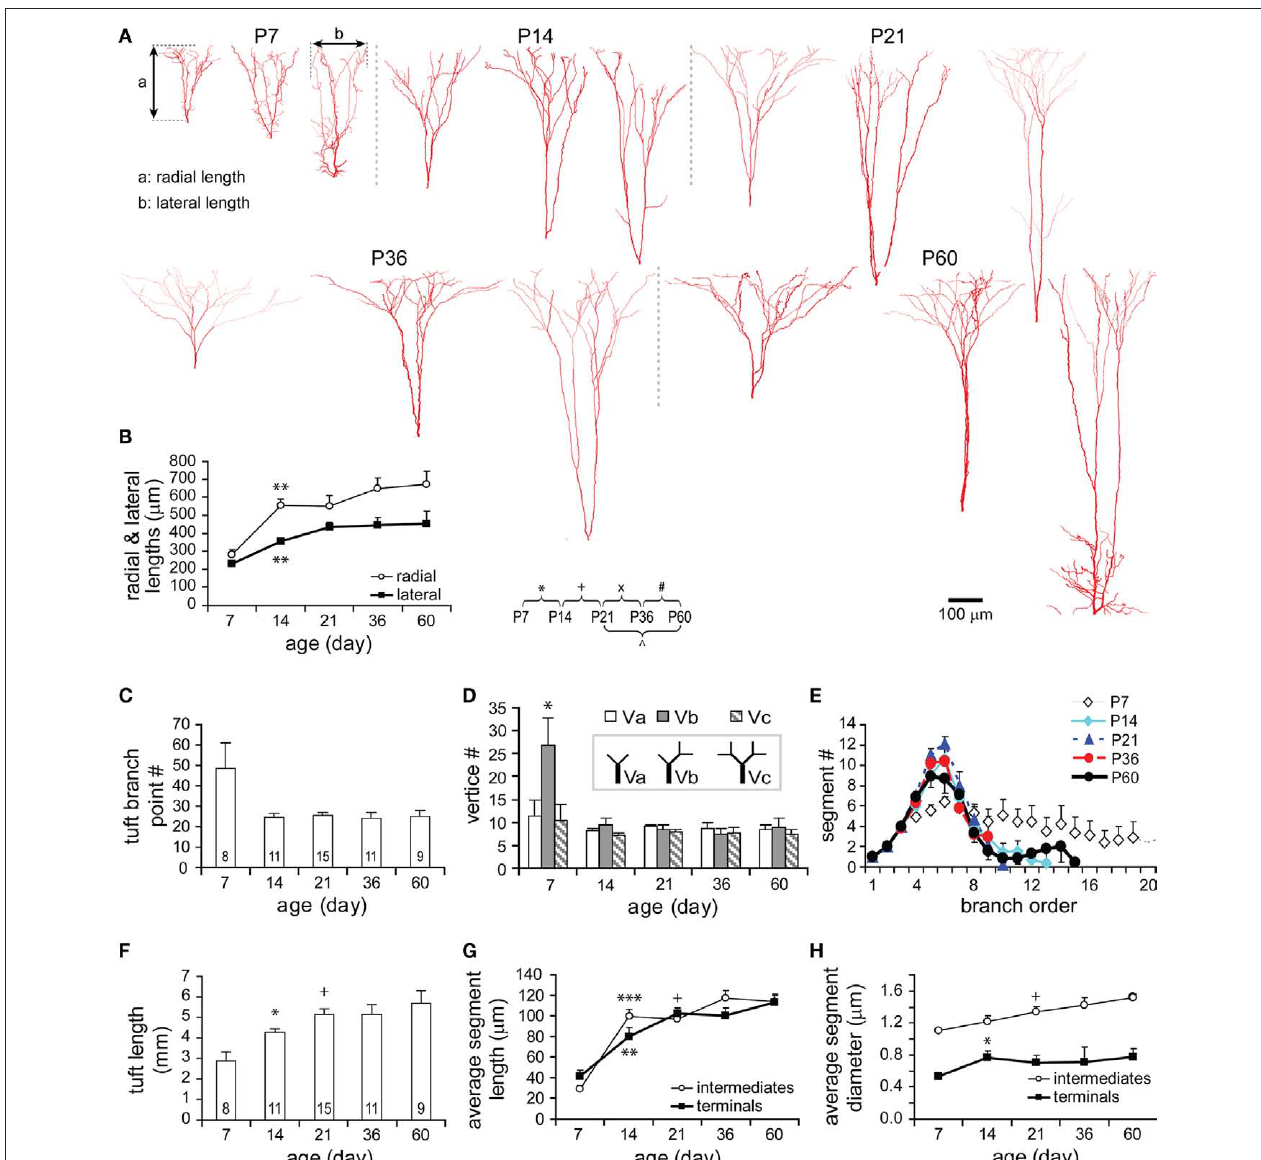
higher at P7 due to filopodia-like segments. (e) Tuft segment number versus branch order at different ages. Except at P7, the distribution curves at other ages virtually overlapped each other with their peaks between fifth and sixth orders. At P7, filopodia-like branches were indicated by higher number of segments at higher-orders ( > seventh order). (F) The total tuft length significantly increased from P7 to P14 and from P14 to P21 and then remained constant. (g) The average segment length of tuft intermediate and terminal segments significantly increased from P7 to P14. Afterward, a further significant increase from P14 to P21 was tested only in terminals. (H) The average segment thickness of tuft segments significantly increased from P14 to P21 in intermediates and from P7 to P14 in terminals (P7: n = 8, P14: n = 13, P21: n = 13, P36: n = 8, P60: n = 9). Note the average segment thickness of tuft intermediates showed a tendency of